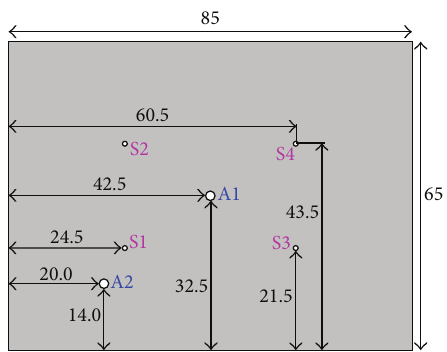
Figure 2: Dimensions of the CFRP plate and positions of the damage (P1, P2, and P3) and the actuator (A1).